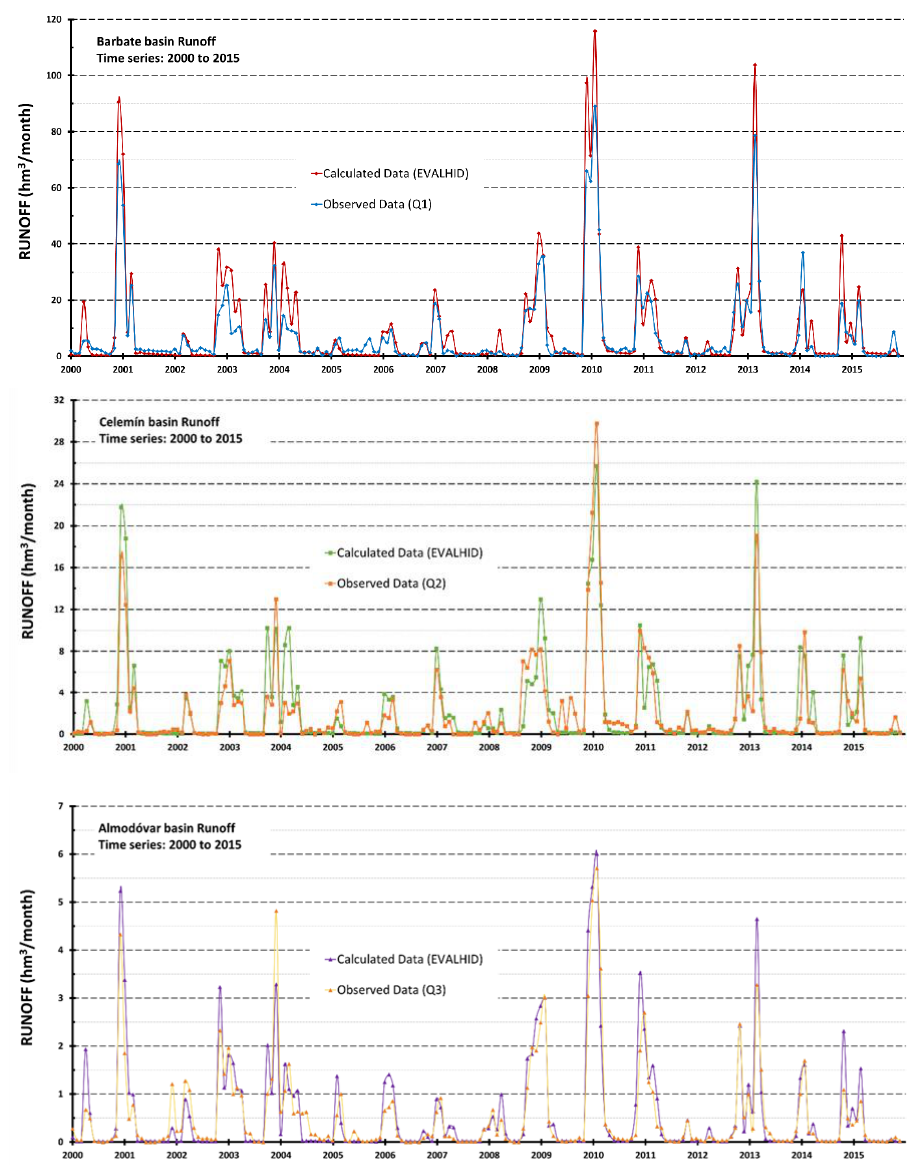
Table 2. Parameters after T-RRM calibration.